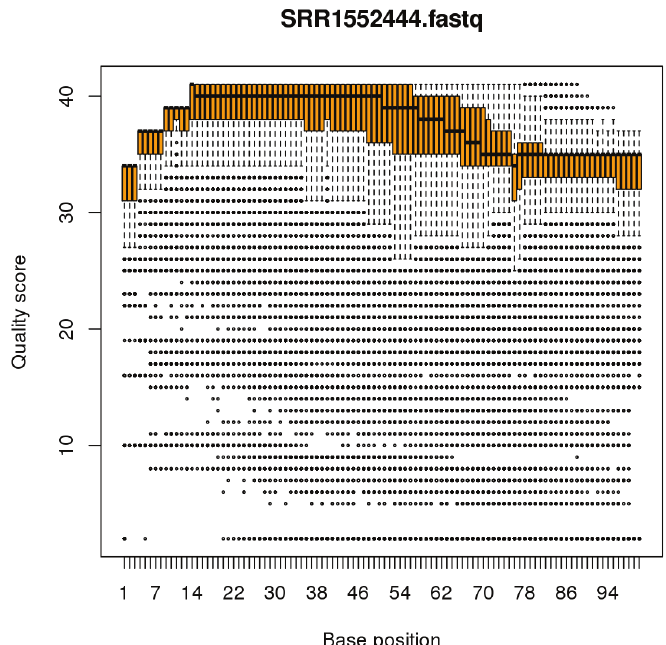
Figure 11. Boxplots of quality scores by base position for the first FASTQ